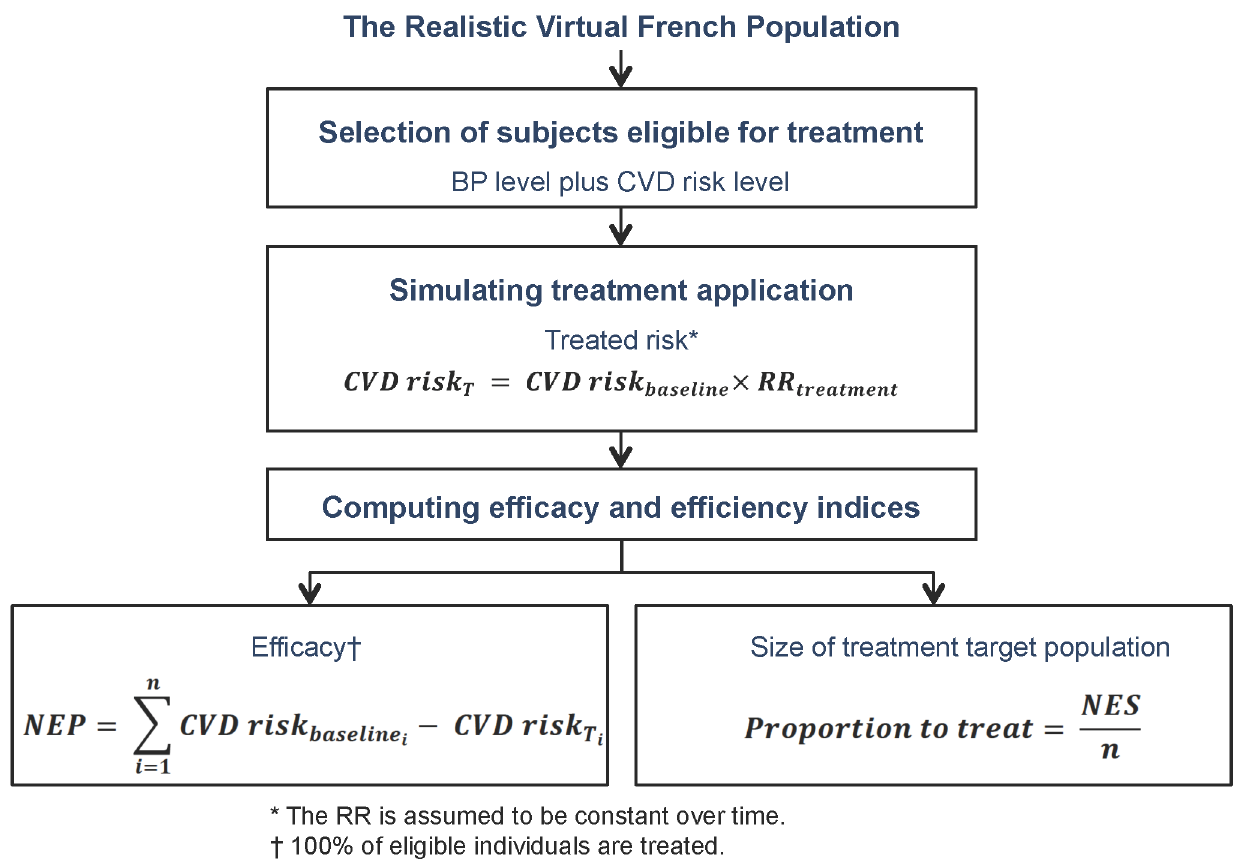
Fig 1. Procedure used to determine the proportions eligible and the number of events prevented thanks to treatment. Abbreviations: CVD, cardiovascular death; NEP, number of events prevented; NES, number of eligible subjects (Modified from reference 2).